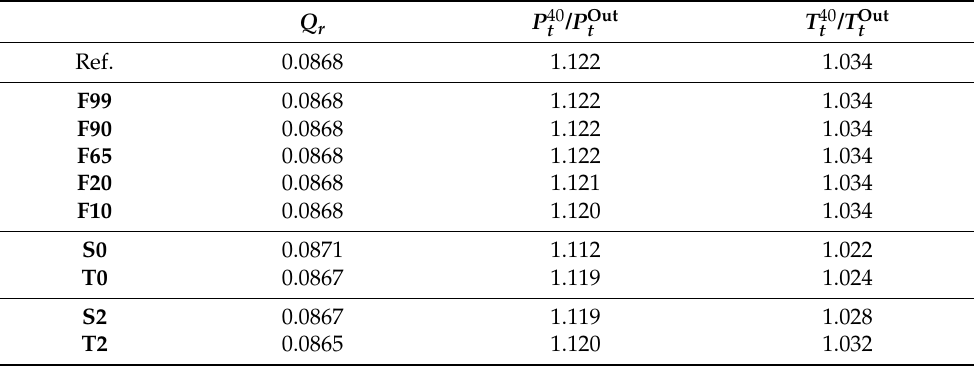
is the perfect gas constant, and L is the radius at mid-vein height) and the ratios of total pressure and temperature between plane 40 and the outlet. The reference corresponds to the integrated combustor/turbine